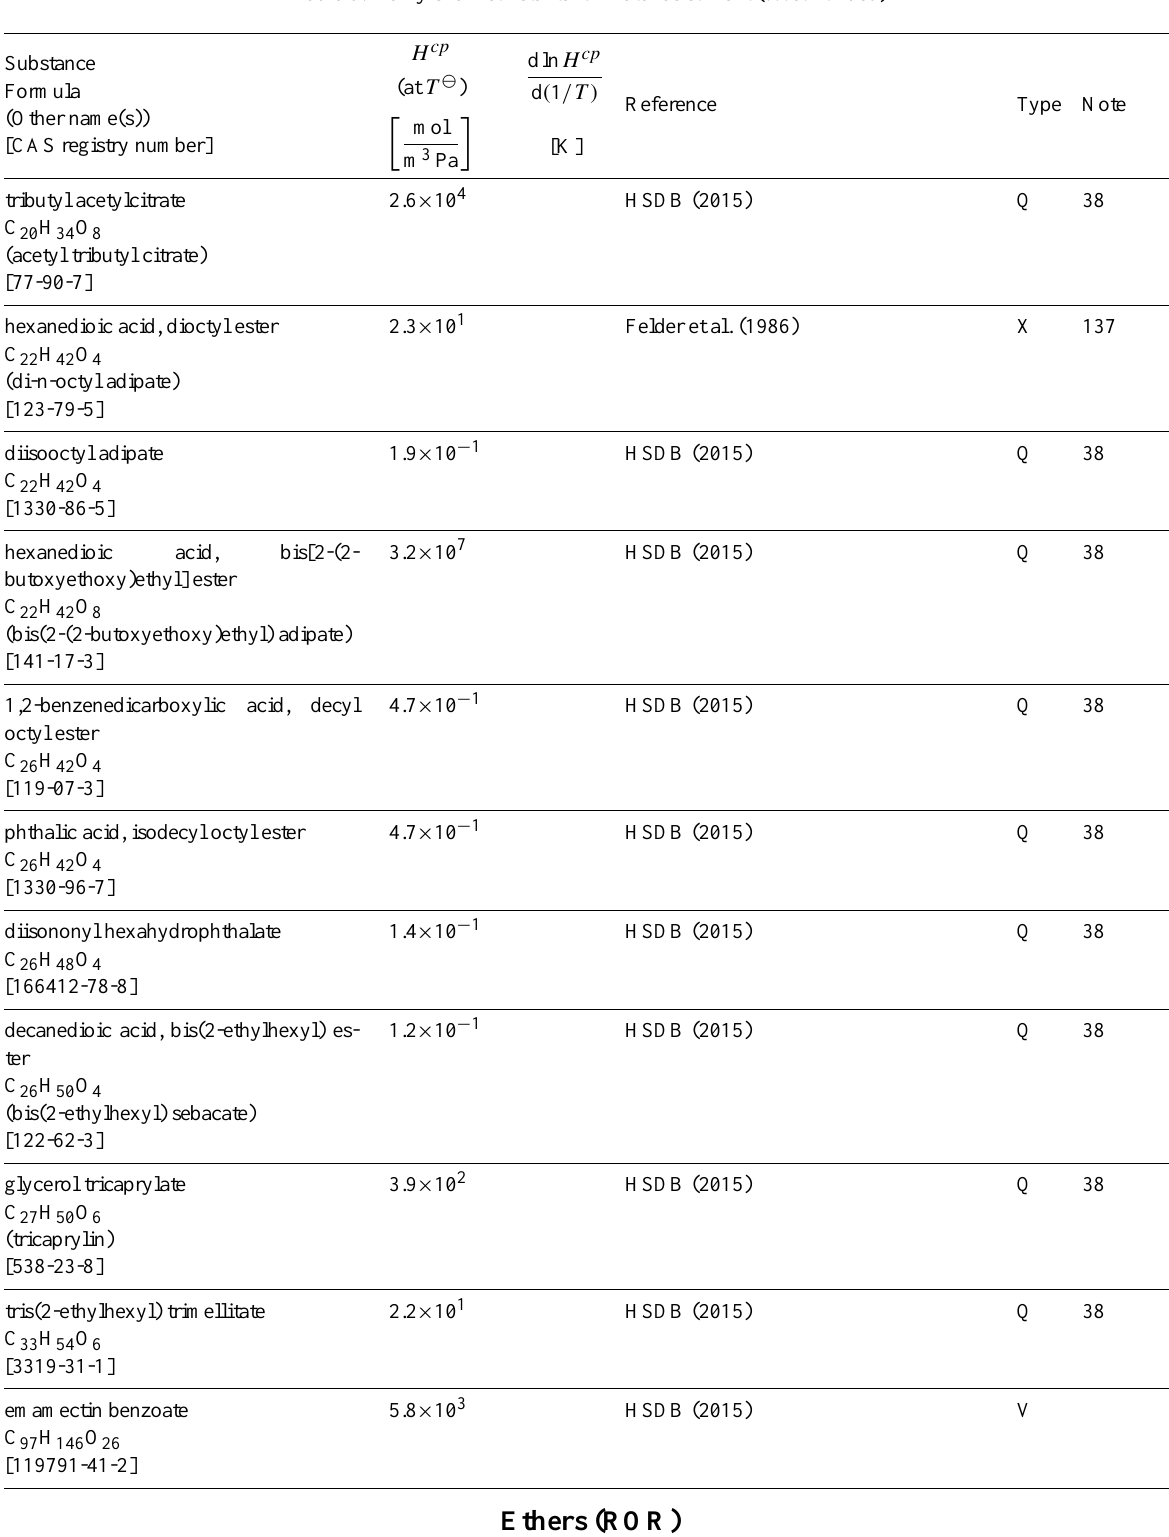
Table 6: Henry’s law constants for water as solvent